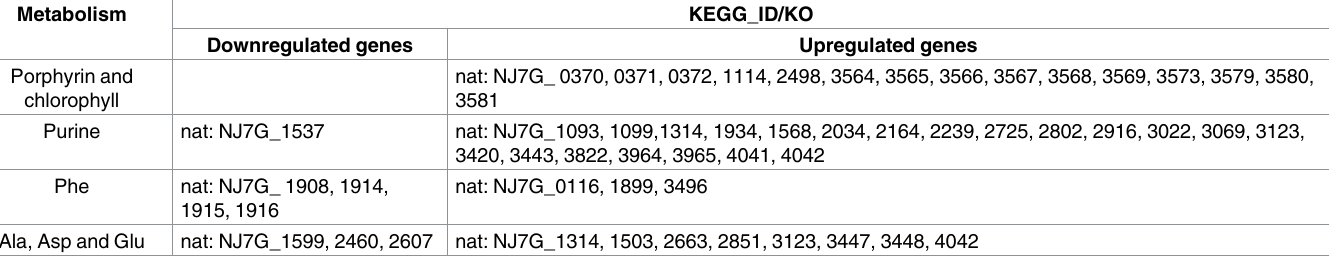
Table 2. KEGG pathway analysis of DEGs (cells in Nat_25 vs